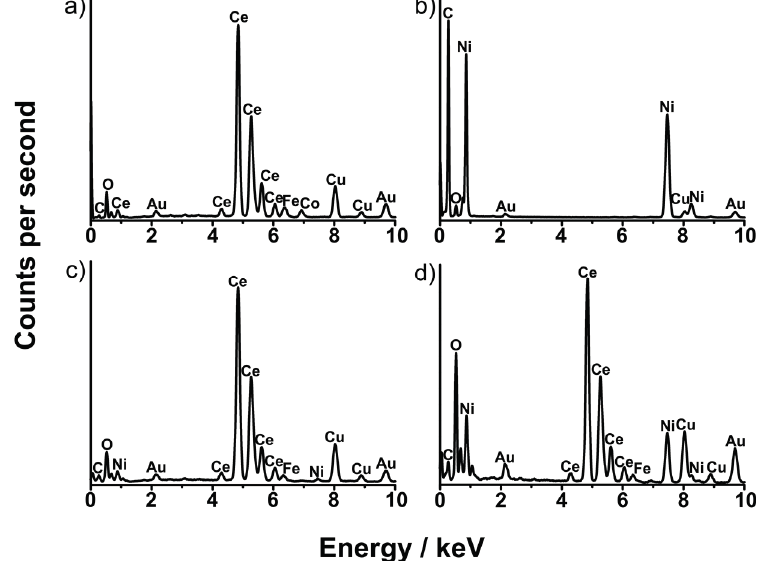
Figure 2. Exemplar EDS spectra of non-annealed and annealed samples. ( a ) CeO